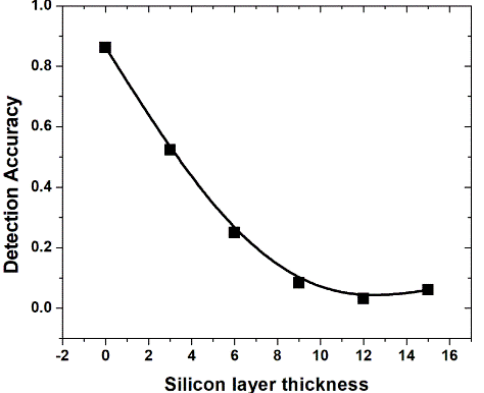
Figure 5. DA with silicon thickness for gas sensing probe graphene layer (L = 13) with 50 nm of Au for gaseous medium refractive index 1 RIU. The square symbols are simulated data points, which are fitted with black